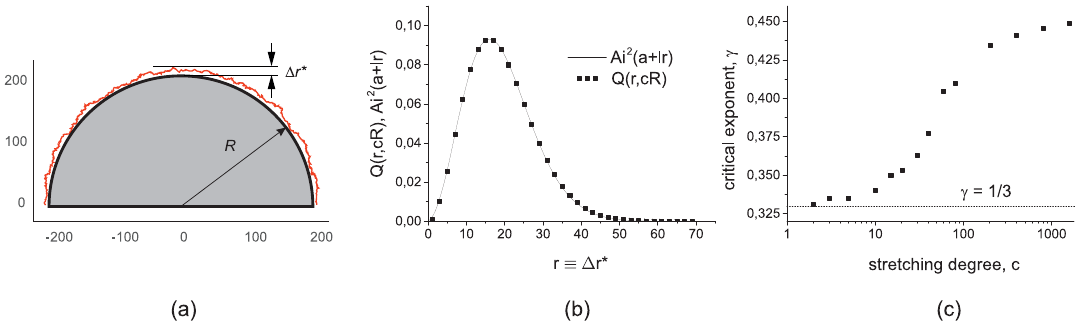
Figure 5 . (a) Comparison of the distribution Q ( r ) with Ai 2 ( a 1 + ar ) for the semicircle radius R = 100 , where a 1 ≈ − 2 . 3381 is the first zero of Ai and a ≈ 0 . 08 ; (b) Dependence of the critical exponent γ on stretching, c : at strong stretching ( c ∼ π exponent 1 , at weak stretching c (cid:29) 1 the exponent γ slowly tends to the Gaussian exponent 1 3